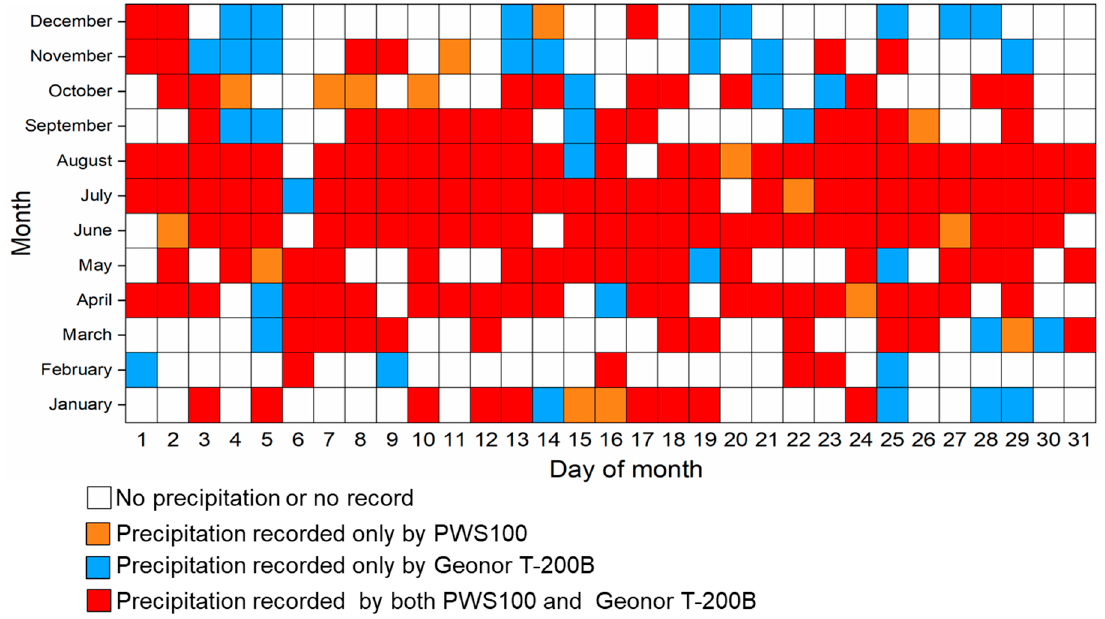
Figure 3. Precipitation days recorded by Geonor T-200B and PWS100.